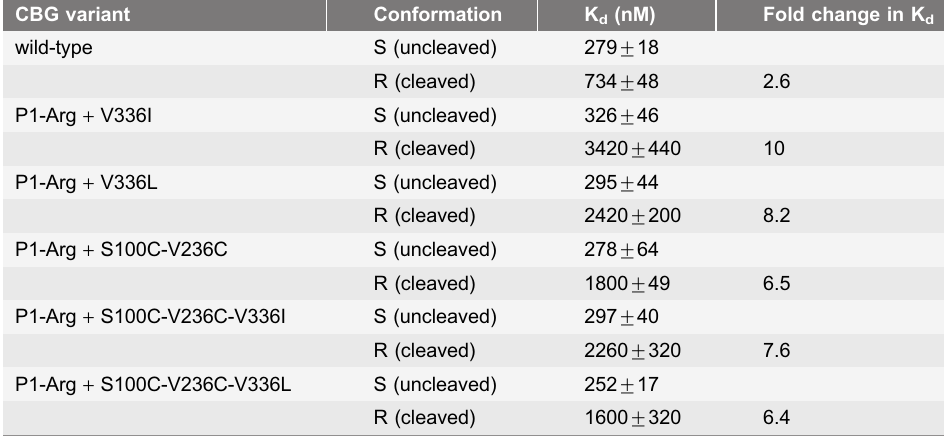
Dissociation constants of various forms of CBG in the S- and R-states. Each pair of results for a given CBG variant represents the K d of the intact S-state and the reactive centre loop-cleaved R-state (larger K d ).